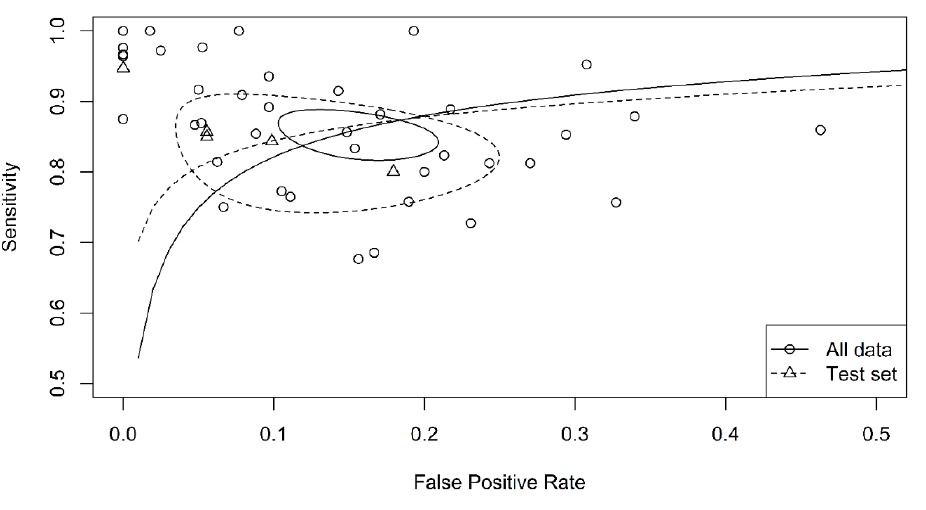
Figure 3. Forest plot and pooled diagnostic odds ratio analysis. Vertical dashed lines indicate 95% CI for the pooled effect. The size of the data markers reflects the weight. Error bars indicate 95% CI.